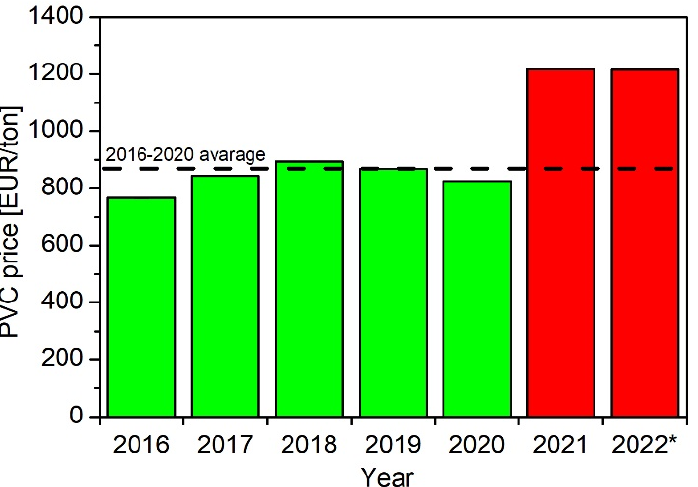
Figure 7. PVC forward-purchase prices on the stock exchange (DPVc1 indexed on Dalian Commodity Exchange) * from January to June.